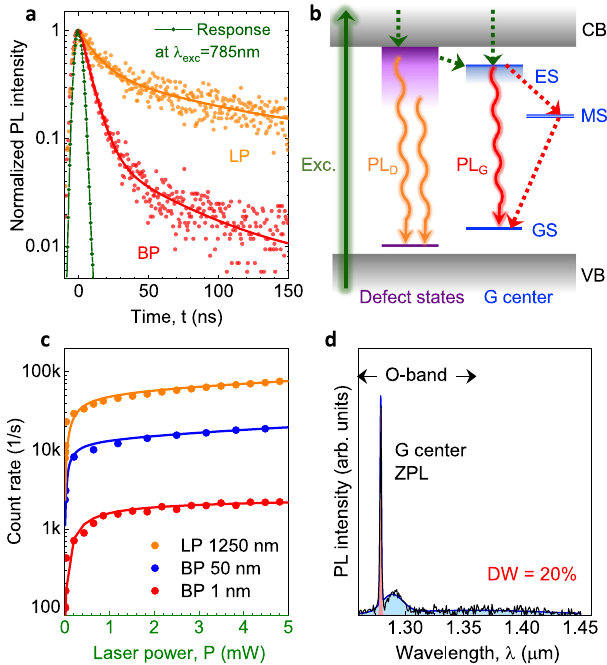
Fig. 3 | Photoexcitation of G centers. a PL decay of the locally created G centers obtained with an LP fi lter λ >1250nm (orange) and a BP fi lter Δ λ =1nm at λ G =1278nm,correspondingtotheZPLoftheGcenter(red).Thesolidlinesare to a bi-exponential decay. The excitation laser pulse at λ exc =785nm is also shown for comparison (green). b Schematic representation of the excitation and recom- bination processes of the G center (PL G ) in the vicinity of bandgap defect states (PL D ). c Count rate of a single G center as a function of the excitation power in the presenceofBGobtainedwithdifferentoptical fi lters:LP fi lter λ >1250nm(orange), BP fi lter Δ λ =50nm at λ =1275nm (blue) and BP fi lter Δ λ =1nm at λ G =1278nm (red).Thesolidlinesare fi ts toEq.(4). d PLspectrumof asingleG center,obtained at P =100 μ W. A multi-Gauss fi t over the ZPL and PSB ’ s (blue solid line) yields a Debye – Waller factor